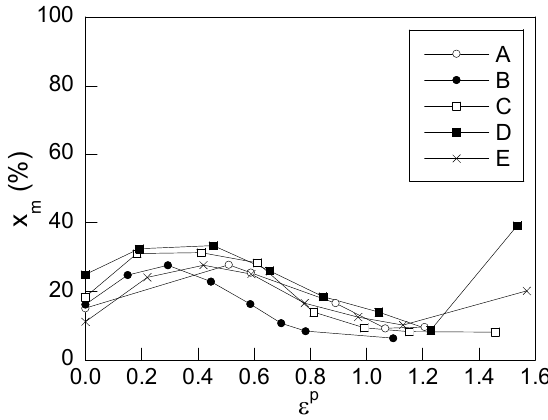
Figure 16. Evolution of the average depth of the external crown with the drawing degree.